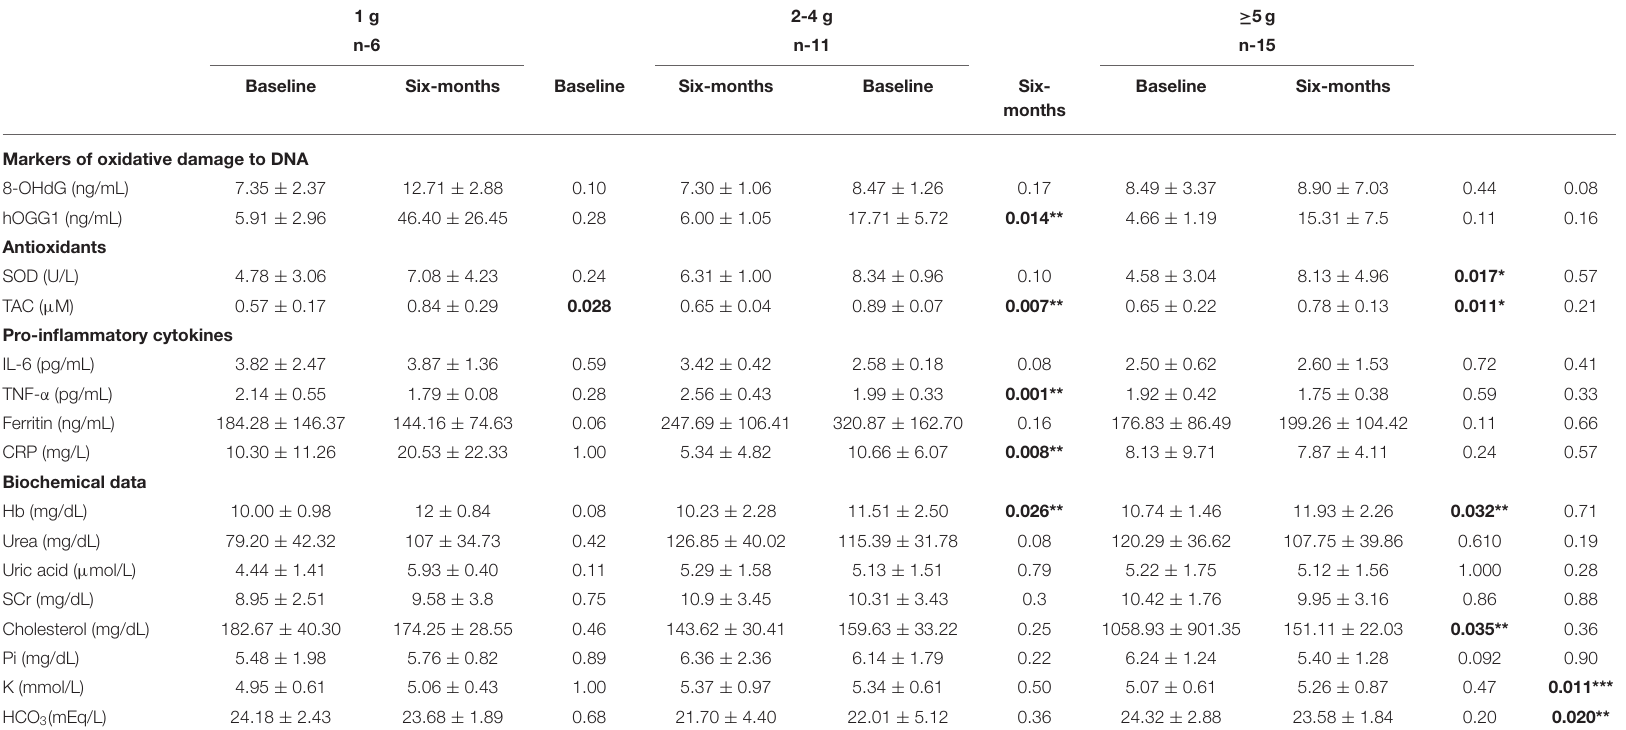
Values are expressed as mean ± standard deviation or standard error of the mean. *** Kruskal-Wallis test. ** Wilcoxon rank test. LPO, Lipoperoxides; NO, Nitric Oxide; 8-IP, 8-isoprostanes; 8-OHdG, 8-hydroxy-2’-deoxyguanosine; hOGG1, Oxoguanine glycosylase; SOD, Superoxide dismutase; TAC, Total Antioxidant Capacity; IL-6, Interleukin 6; TNF- α , Tumor necrosis factor alpha; Hb,hemoglobin; SCr,Serum creatinine; K,Potassium; Pi, Phosphate; Cl,Chlorine; CRP, C Reactive Protein; HCO3, Bicarbonate. It was not possible to measure the glomerular filtration rate since its value is < 10 mL/min/1.73 m 2 . Data in bold are statistically significant